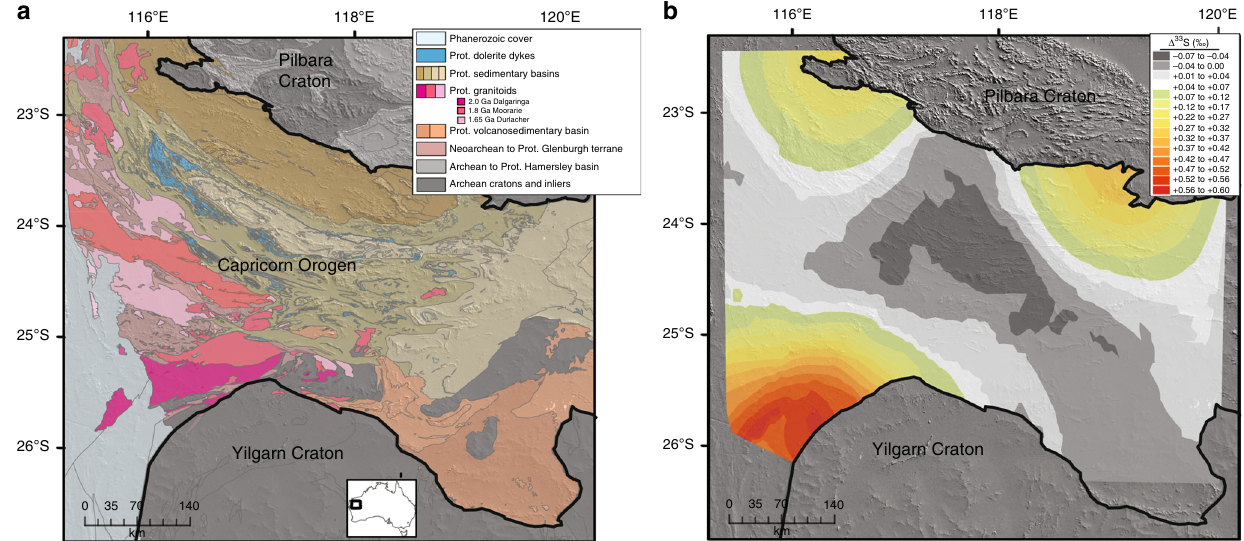
Fig. 3 Interpolated model of MIF-S within Capricorn Orogen. a Location and geology of the Proterozoic Capricorn Orogen between the Archean Pilbara and Yilgarn cratons in Western Australia. b Interpolated model of Δ 33 S for Proterozoic samples of the Capricorn Orogen by ordinary kriging to show that MIF-S occurs in Proterozoic rocks located along the margins of the Archean Pilbara and Yilgarn cratons